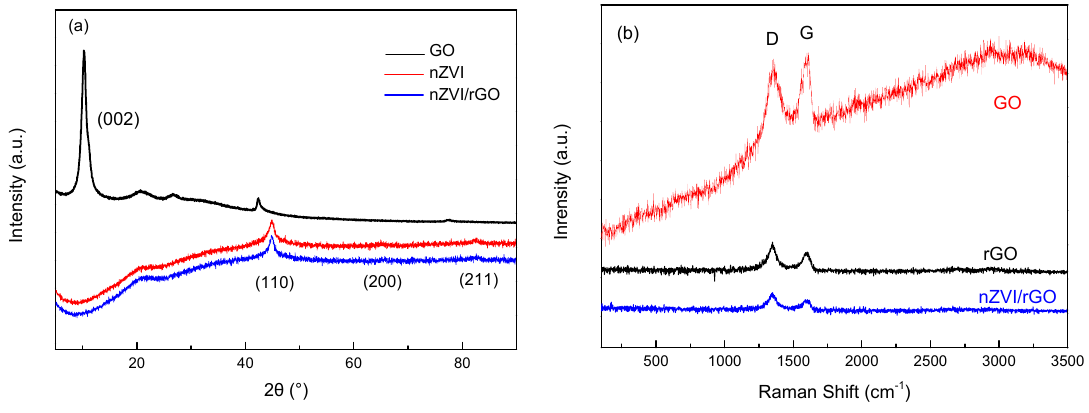
Figure 5. X-ray diffraction (XRD) patterns of nZVI and nZVI/rGO ( a ); Raman spectra of GO, nZVI, and nZVI/rGO ( b ).